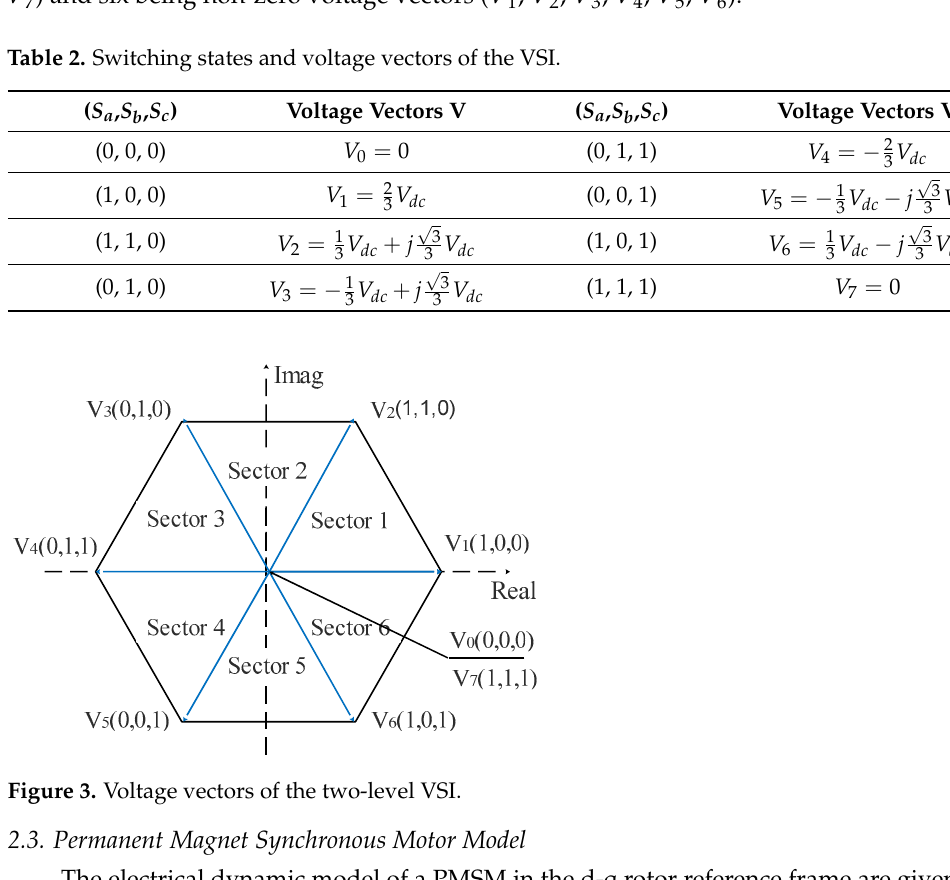
Table 1. Electric vehicle parameters.